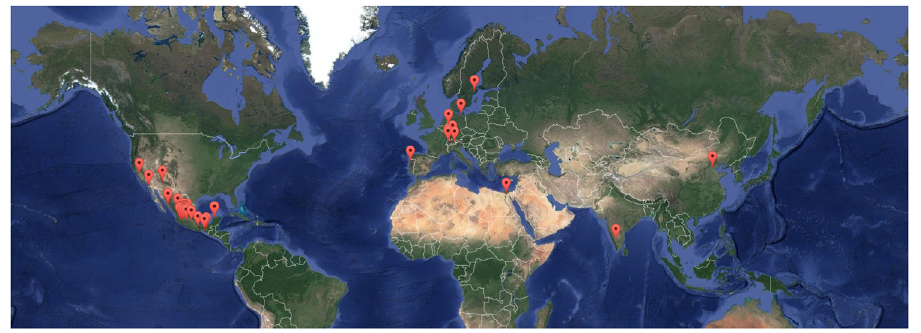
Figure 10: Worldwide locations of thermal plants ( nonpower - generation ) using PTC systems.